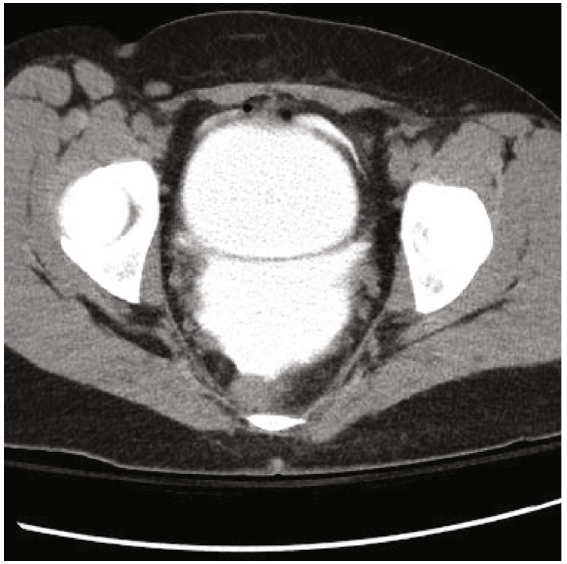
Figure 1: CT cystogram showing contrast extravasation into peritoneum and a small amount of free peritoneal